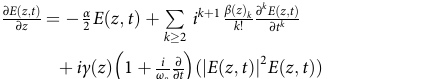
spanning beyond 100 THz. This process is enabled by adiabatic SH and SF translation of a broadened near-VIS supercontinuum comb in a chirp-modulated taper AlN waveguide. The upcon- verison process not only maintains a high degree of coherence but also shows off-chip ef fi ciency up to 6.6% (average power of 0.56 mW). Such coherent and ef fi cient UV microcombs are fea- sible for on-chip UV spectroscopic sensing and atom-photonic interfaces. Our result suggests that chirp-modulated adiabatic waveguides are important media for ultrafast nonlinear optics with less susceptibility to the degraded pulse peak power with the propagation distance. The approach can be also adopted to other non-centrosymmetric waveguide materials such as lithium nio- bate 24 , gallium nitride 41 , and gallium phosphide 42 by taking full advantage of their intrinsic χ (2) and χ (3) nonlinearities.